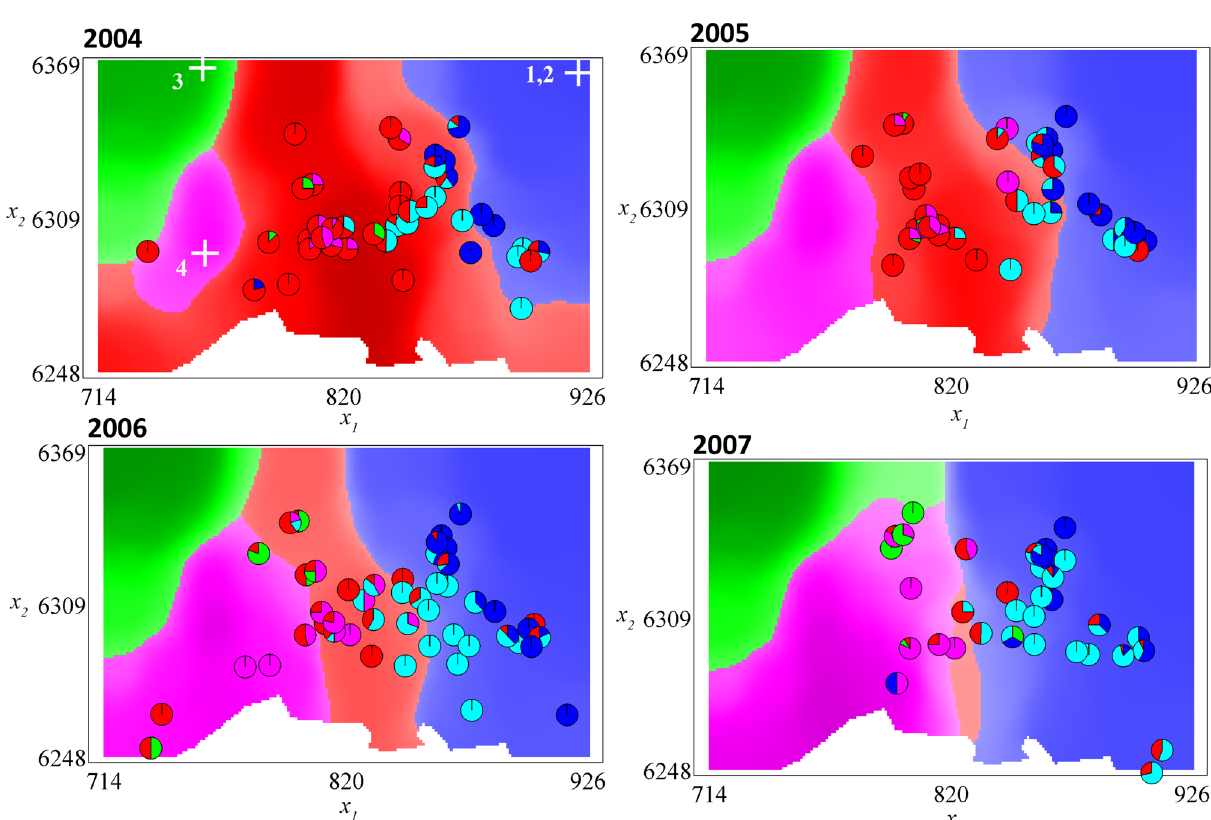
Figure 2. Proportions of the classical and emerging strains in the landscape: data and simulations. The colors of the shaded regions indicate which strain is the most prevalent . The red regions correspond to the CS strain; light blue and blue: ES 1, ES 2 (these two strains have the same density, only ES 1 is represented); green: ES 3 ; pink: ES 4 . The pie charts describe the relative proportions of the strains found in the data (same color legend). The white crosses on the 2004 panel represent the estimated sites of introduction. The simulation results presented here correspond to the middle of the intra-annual stage (2nd week of June), and were obtained with the MLE (cid:31) ∗